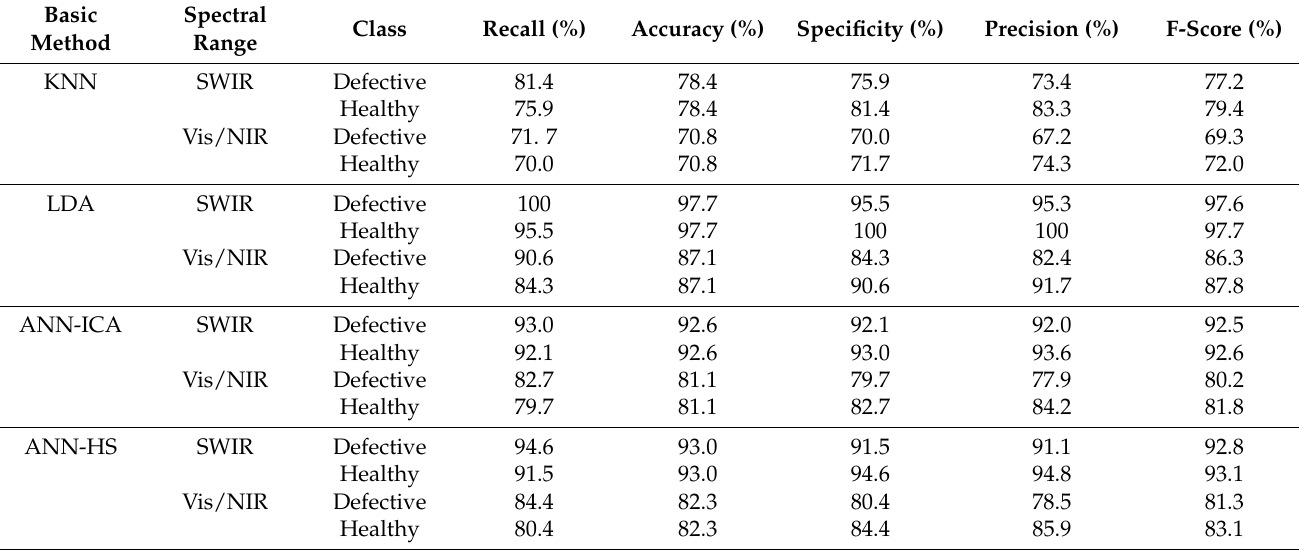
Table 6. Different criteria for evaluating the performance of different classifiers to classify potatoes in 200 iterations.